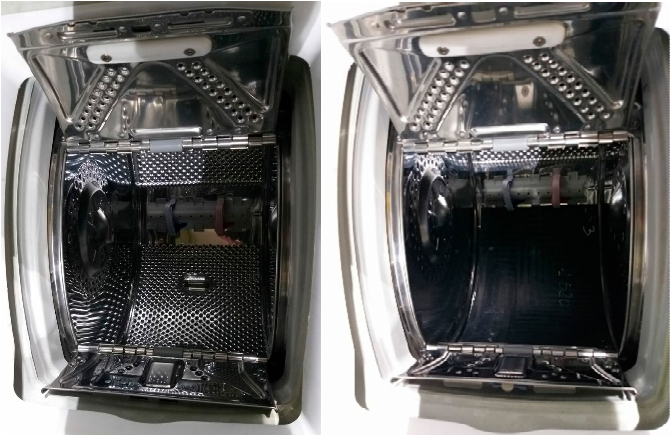
Figure 18. View of the direct-drive horizontal-axis washer. Left view: empty drum condition. Right view: insertion of rubber plates (black colored) inside the drum to emulate the laundry unbalance (test with unbalance mass of 1505 g).